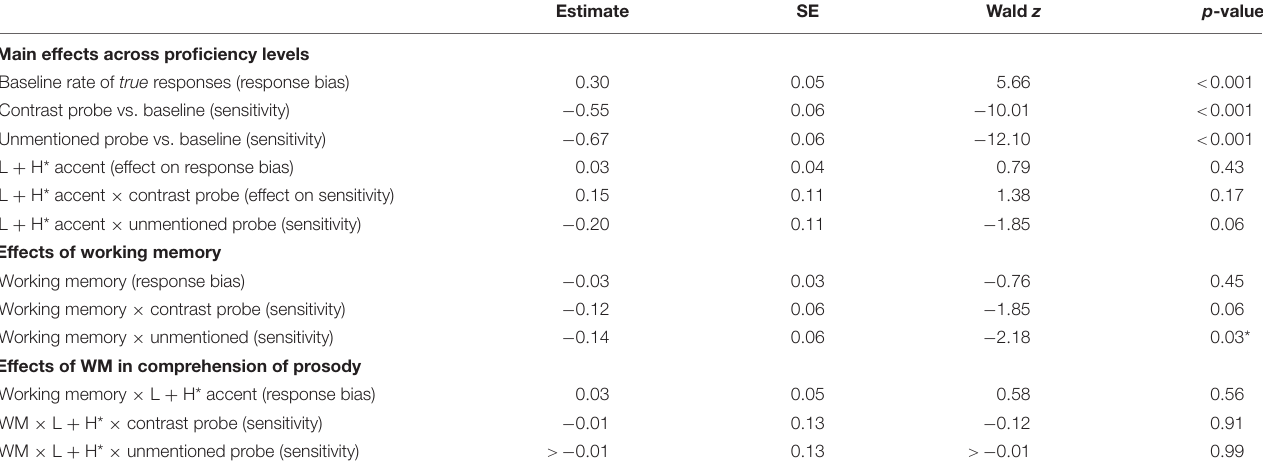
Estimate SE Wald z